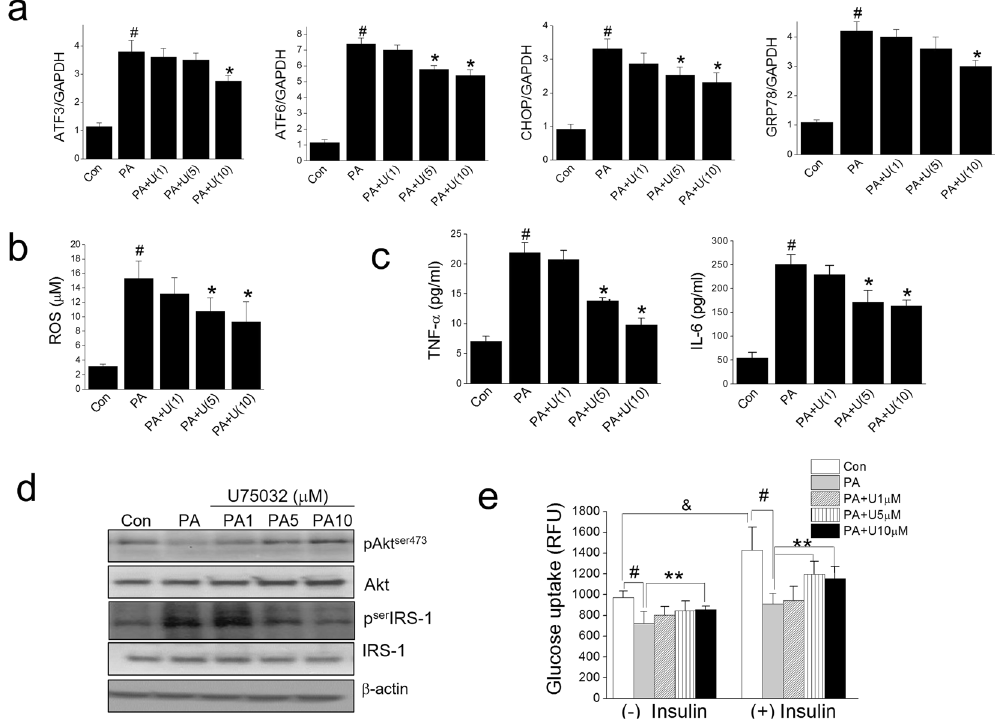
Figure 4. Effects of BLT1 receptor antagonist, U75032 on PA-induced lipotoxicity. Differentiated C2C12 myotubes were exposed to different concentrations of U75032 (1, 5, 10 μ M) for 1 h and then treated with PA (750 μ M) in the presence of U75032 for 12 h (qPCR) or 24 h (ELISA). Levels of ER stress markers were determined by qPCR ( a ). ROS production was assessed using AmplexRed ( b ). Levels of pro-inflammatory cytokines were determined by ELISA ( c ). Akt and serIRS-1 phosphorylation was assessed by western blotting ( d ). After 24 h of PA treatment, insulin (1 μ g/ml) was added for 30 min, and then glucose uptake was determined by 2-NBDG ( e ). The results of the western blotting are shown as the representative of three independent experiments ( d ), and other results are expressed as the means ± SDs of three experiments performed in triplicate. # P < 0.05 vs . non-treated controls, * P < 0.05, ** P < 0.01 vs . PA alone, & P < 0.05 vs . ( − )